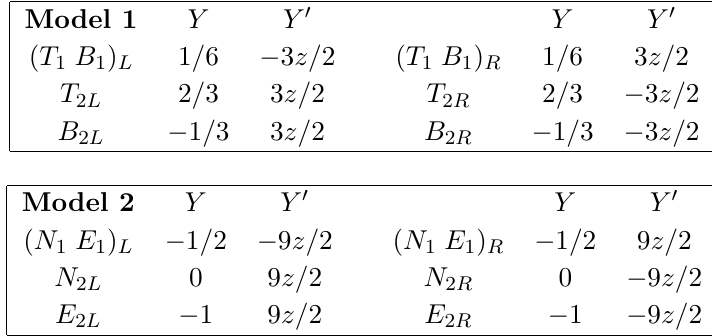
Table 2 . Two minimal extensions of the fermion sector with U(1) 0 anomaly cancellation (top: vector-like quarks, bottom: vector-like leptons). The Y 0 hypercharges are given in terms of z